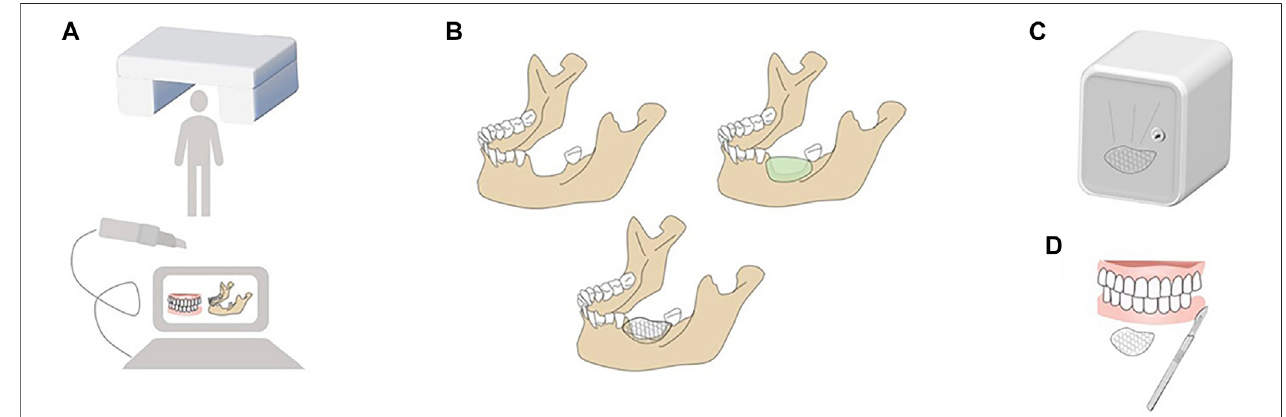
FIGURE 2 | Protocols of modern 3D CAS. (A) Information acquisition: Information is required by intraoral scanning and digital imaging and communications in medicine(DICOM)recordingremainingalveolarbone,positioningofcriticalanatomicstructureandsofttissuecondition. (B) PlanningandVirtualoperation:Planningisto design the optimal scheme according to the size and range of defects virtually; Virtual operation is to de fi ne the best osteotomy boundary or bone grafting range according tothe tumor boundary or defect condition in thesoftwaretorealizevirtual positioning design. (C) 3-D printing: 3D printing isan additional manufacturing technique that deposits materials layer by layer to construct predesigned models. (D) Surgery and Postoperative Analysis: Precise osteomy and accurate localization of the implant are prerequisites of successful operation. And postoperative CT scan is necessary to evaluate the designed and actual results and analyze why deviations occur and how to deal with